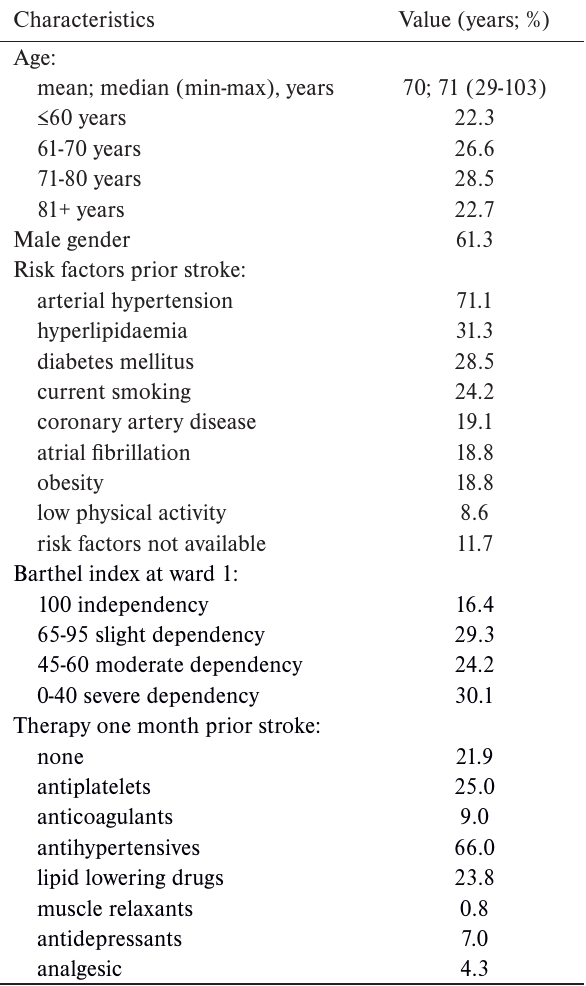
Table 1. Baseline characteristics of patients (n=256).